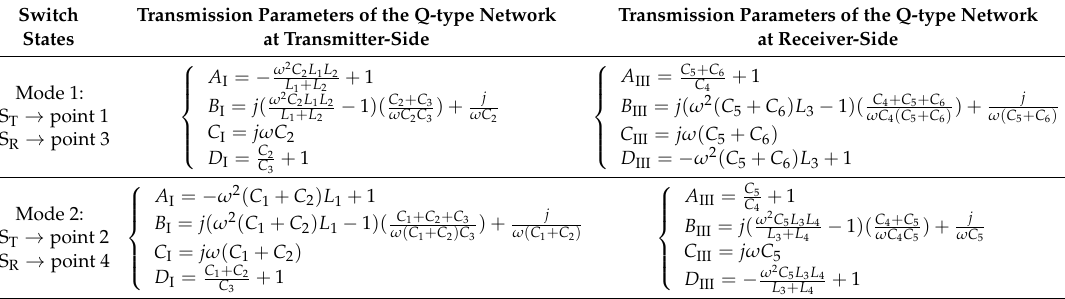
Table 3. Two operating modes of the modified WPT